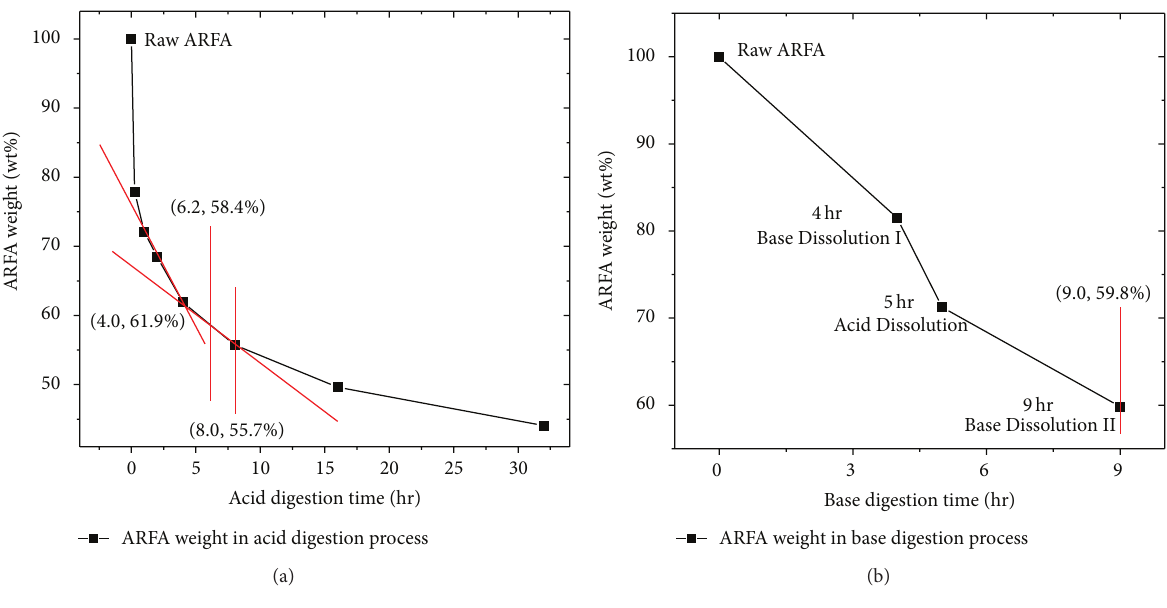
Figure 1: Weight changes of ARFA in acid (a) and base (b) digestion processes.